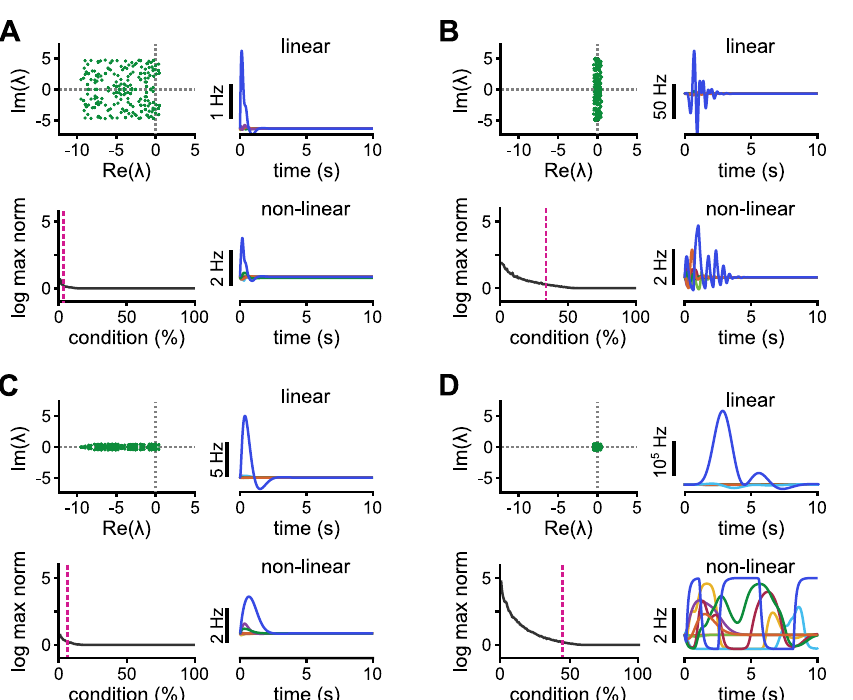
Fig 2. Eigenspectra and dynamics of the corresponding networks. A–D , Four cases of eigenspectra and dynamics of the corresponding network of size N = 200. In each panel, clockwise: The spectrum; linear dynamics; non-linear dynamics; the logarithm of the maximum norm of the firing rate per initial condition. The same initial condition that elicits the maximum norm is used for both linear and non-linear dynamics. Pink dotted line indicates the percentage of conditions whose norm is amplified by at least 50%. The feedforward structure is taken from a stability-optimised circuit [8] and its Frobenius norm is fixed to 75. Real and imaginary parts follow an uniform distribution with diameters d im and d re , respectively. A , When d im = d re = 10, only 1% (2 out of 200) of the conditions are slightly amplified. B , When d im = 10 and d re = 1, the system is capable of more amplification. C , Here, d im = 1 and d re = 10, surprisingly creating more amplification compared to the case shown in panel A. D , When d im = d re = 1, the system amplifies almost half of the initial conditions. The dynamics, given an initial condition of norm 1, reach the value of * 10 5 Hz in the linear case and consequently long-lasting dynamics in the non-linear